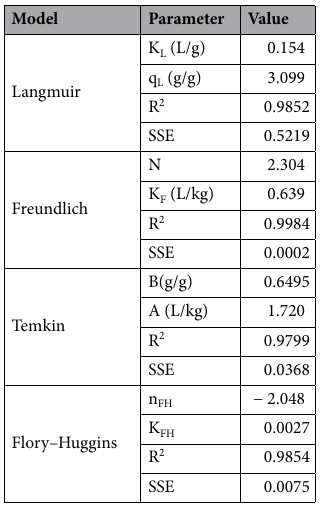
Table 2. The adsorption isotherm parameters for bromophenol blue adsorption onto